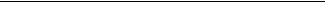
possible ( z e ; z m ) charges. In this case, we can add Abelian line operators with ( q; g ) = (1 ; 0) 3 3 and ( q; g ) = (0 ;